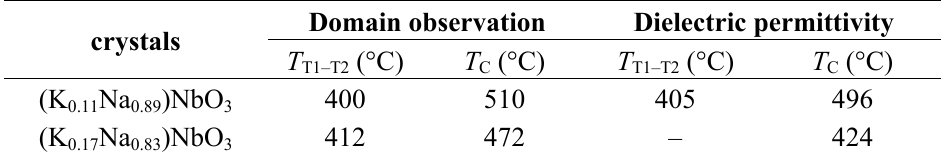
Table 2. The phase transition temperatures obtained by domain observation and dielectric